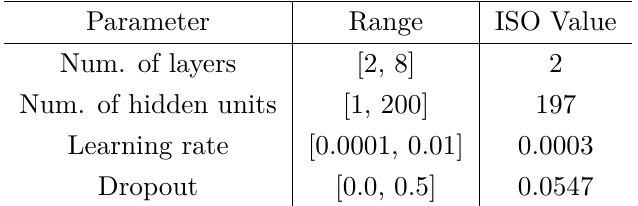
Table 3. Hyperparameter ranges for Bayesian optimization of fully connected networks. to classify signal vs background. The model had dropout [37, 38] with value 0.2388 on